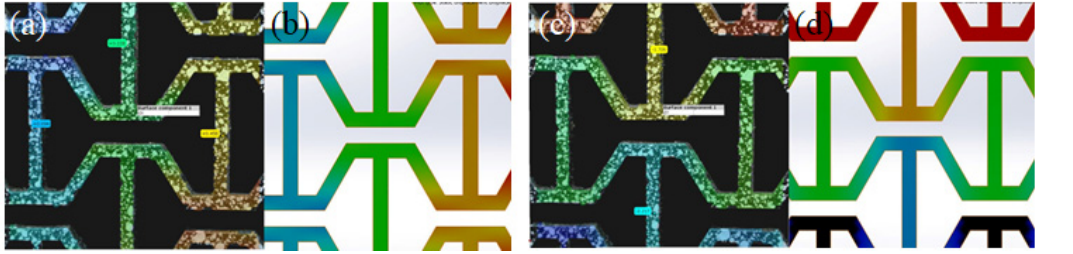
Figure 10. Deflection pattern between the tensile test and FEA for loading in ( a , b ) the x-direction and ( c , d ) y-direction.